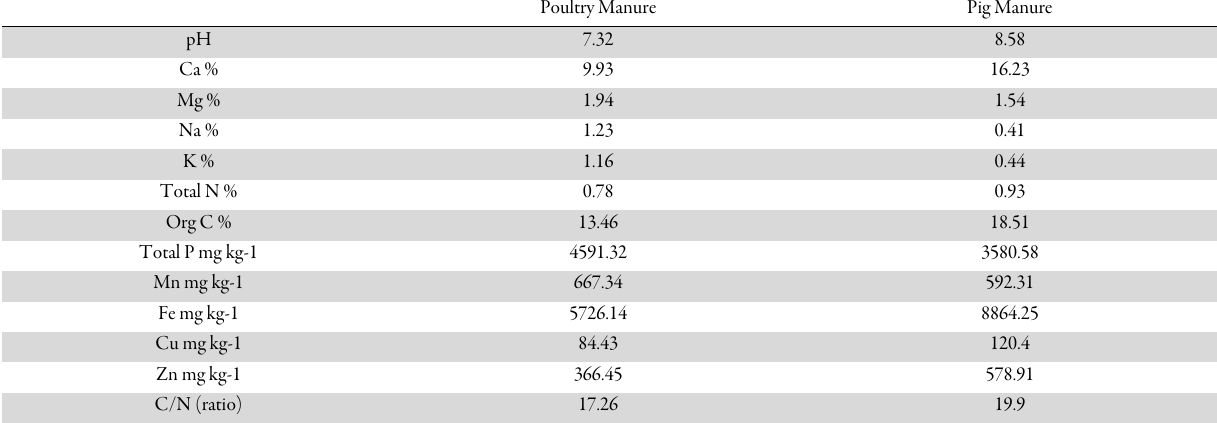
Table 2. Chemical analysis of poultry and pig manure used in this study